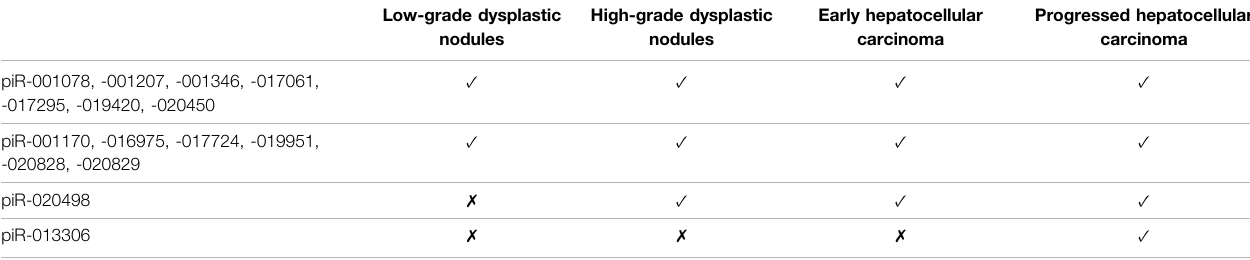
TABLE 2 | Changes of piRNA expression during human liver